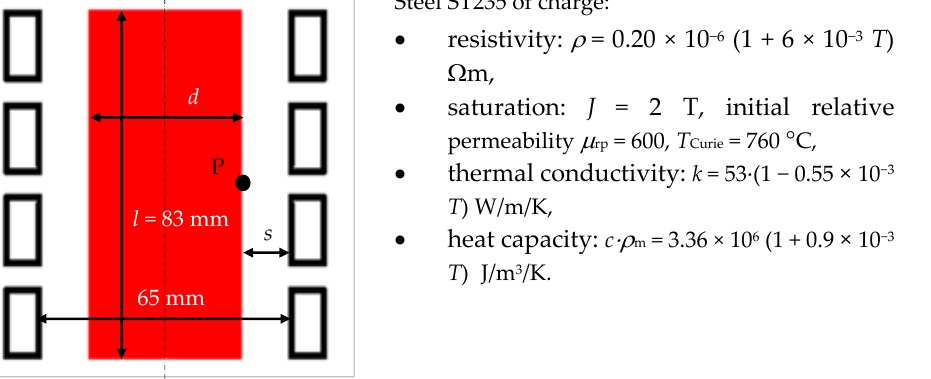
Figure 5. Example of an IHS with a four-turn inductor.